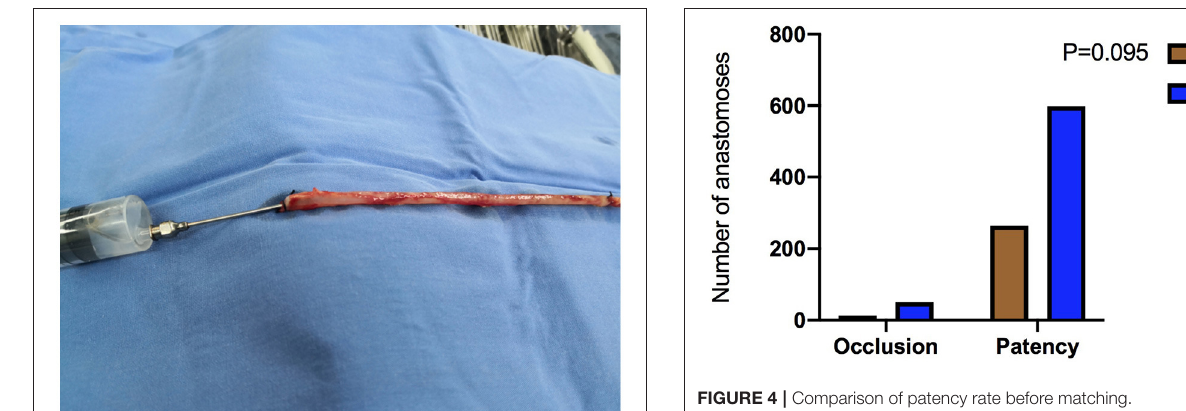
FIGURE 4 | Comparison of patency rate before matching.